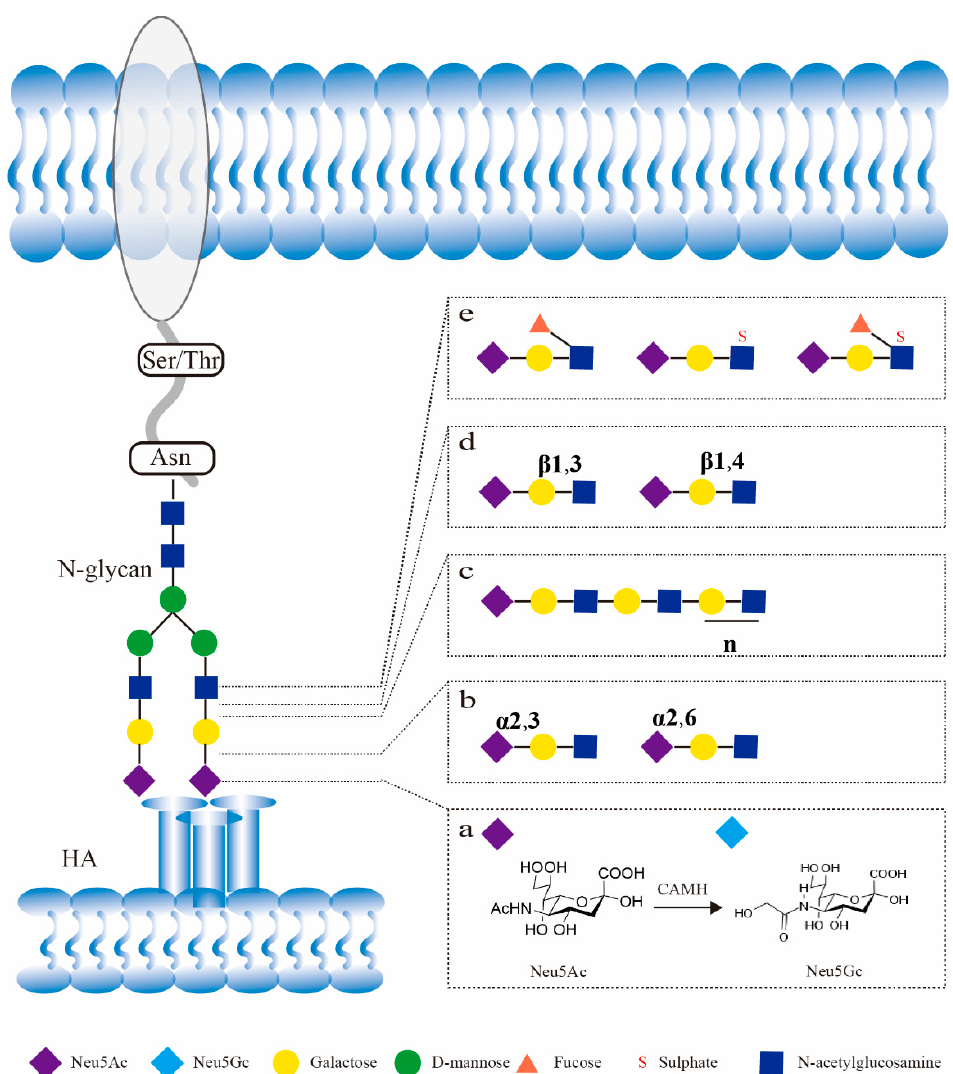
Figure 1. Influenza virus binds different sialylated molecules. ( a ): Neu5Ac and Neu5Gc are two forms of sialic acids. ( b ): Terminal sialic acids can be linked to secondary terminal galactose via α -2,3 and α -2,6 glycosidic bonds to form α -2,3 sialic acids and α -2,6 sialic acids. ( c ): Sialylated glycan molecules with extended poly-LacNAc. ( d ): Gal-GlcNAc can be linked by β -1,3 or β -1,4 glycosidic bonds to form different sialylated molecules. ( e ): GlcNAc can be fucosylated or sulphated to form different sialylated molecules.